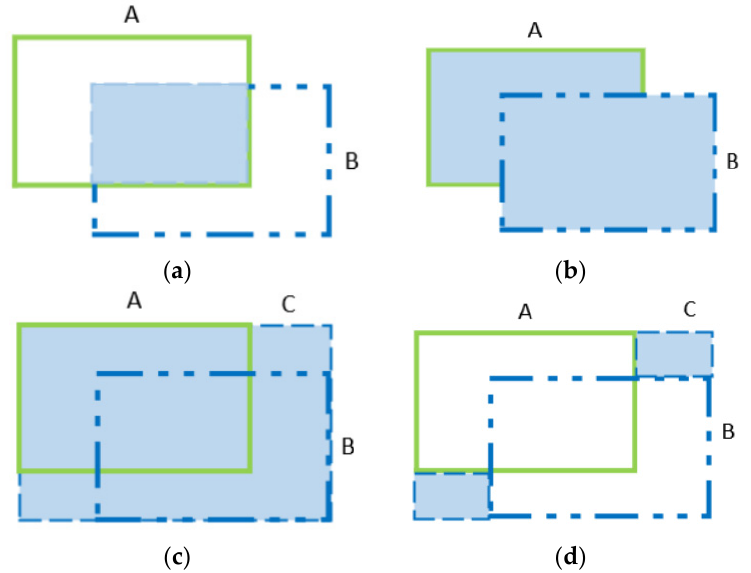
Figure 3. The details of GIOU. ( a ) A ∩ B; ( b ) A ∪ B; ( c ) C; ( d ) C − (A ∪